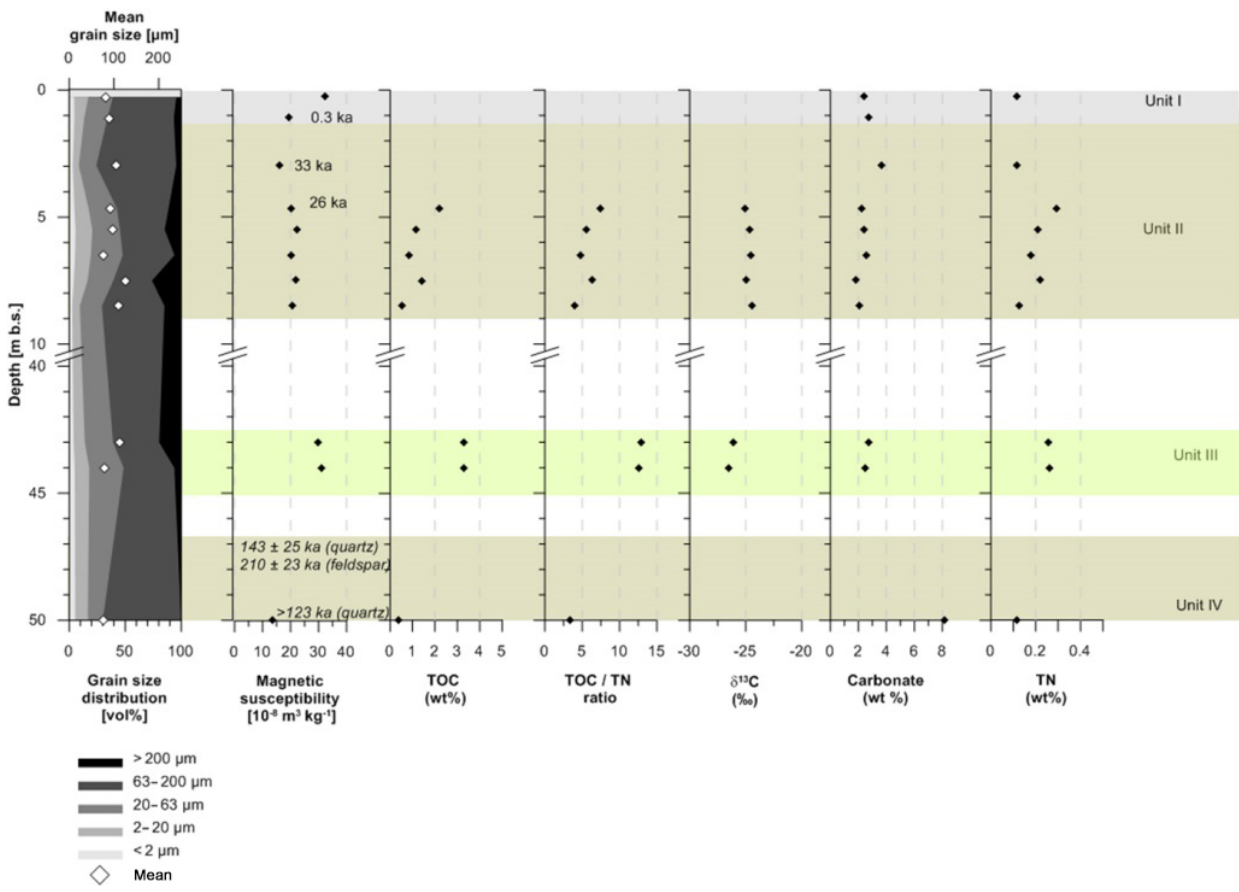
Figure 9. Diagram presenting grain size distribution, MS, TOC and TOC / TN, δ 13 C, and carbonate records for section A.